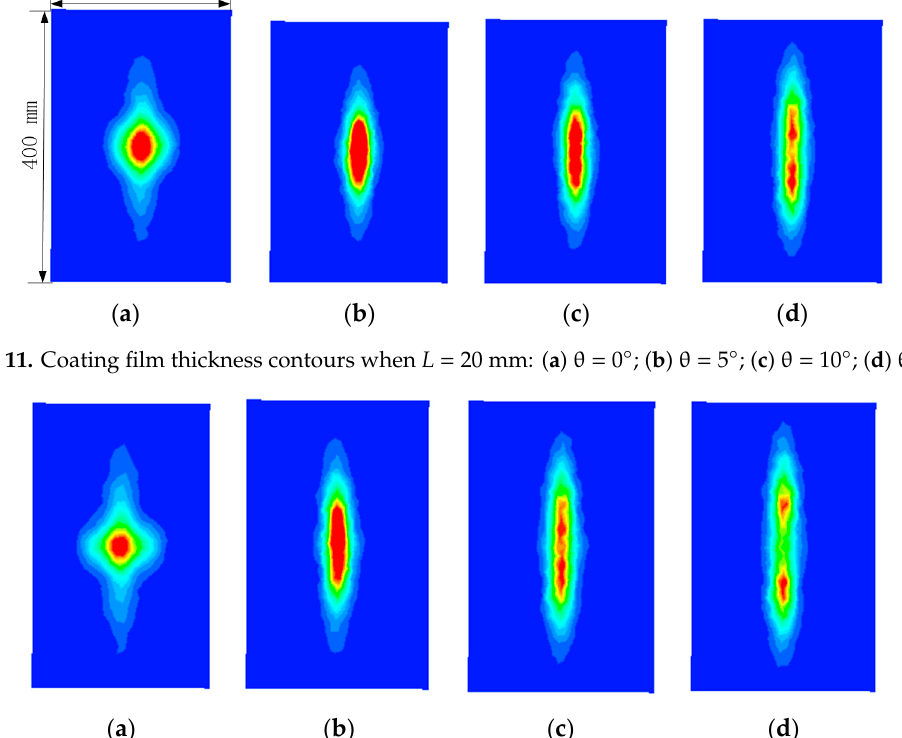
Figure 12. Coating film thickness contours when L = 30 mm: ( a ) θ = 0°; ( b ) θ = 5°; ( c ) θ = 10°; ( d ) θ = 15°.